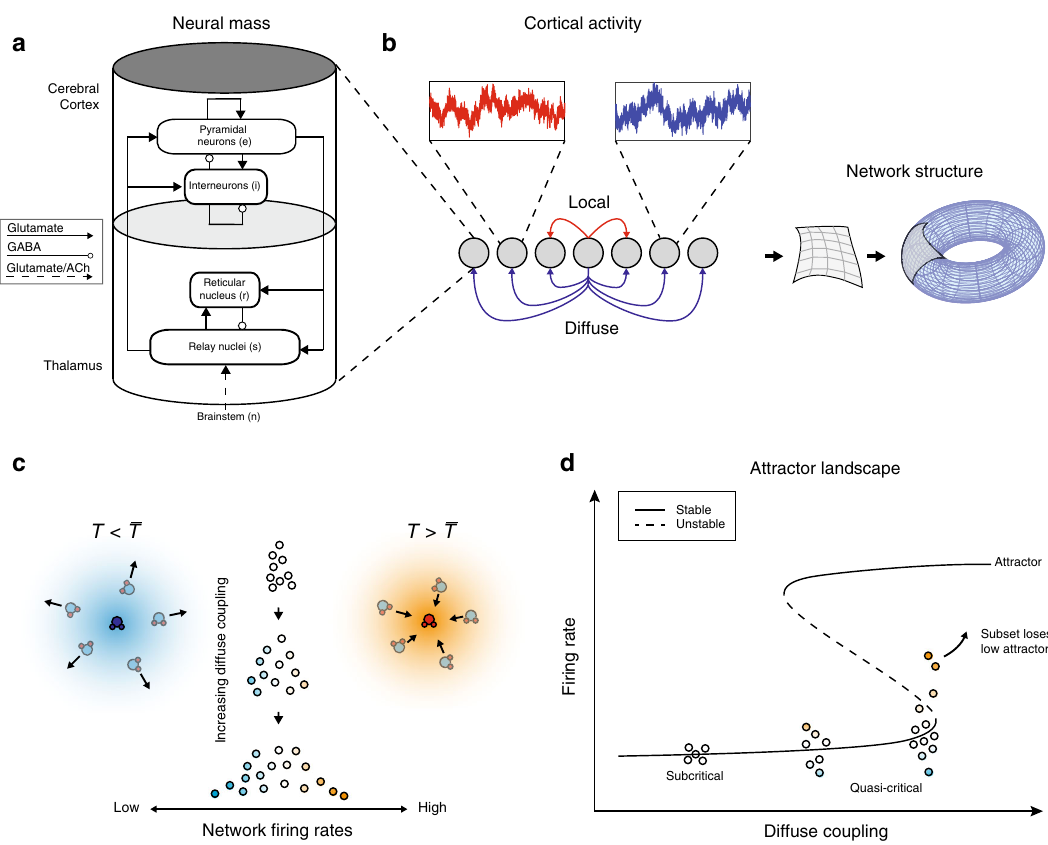
Fig. 1 Model schema. a Corticothalamic neural mass model implemented at each node of the network: each mass was comprised of four distinct cellular populations: an excitatory cortical pyramidal cell ( “ e “ ), an inhibitory cortical interneuron ( “ i ” ) , an excitatory, speci fi c thalamic relay nucleus ( “ s ” ), and an inhibitory thalamic reticular nucleus ( “ r ” ) , with intranode corticothalamic neural mass coupling de fi ned according to known anatomical connectivity. b Connectivity schematic — local and diffuse coupling with periodic boundary conditions (toroidal topology). c Distribution of nodal fi ring rates across the network — an increase in diffuse coupling subsequently increases the standard deviation of fi ring rates, with the tails of this distribution having greater above (and below) average values. The cartoons depict subsets of a thermal system with temperature T below (left) and above (right) the average T. d Qualitative effect of increasing diffuse coupling in the presence of heterogeneity on the attractor landscape: increased diffuse coupling shifts all nodes towards their local saddle-node bifurcation point. In the middle of this continuum, the heterogeneous inputs allow a particular subset of nodes (shaded orange) to cross this point and the activity of these nodes begins to move towards the high fi ring